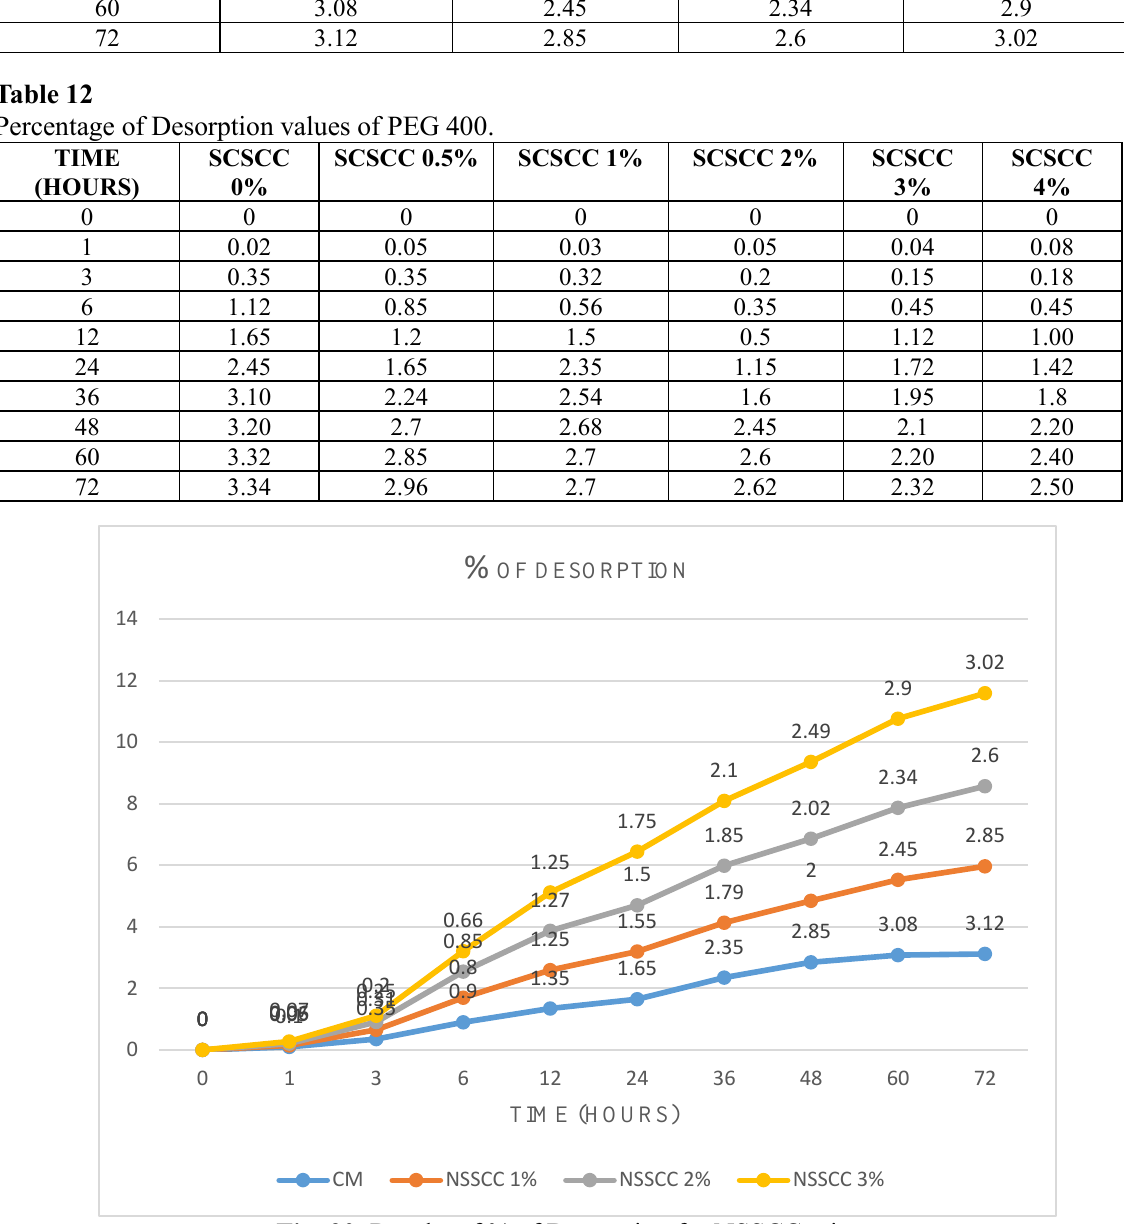
Fig. 30. Results of % of Desorption for NSSCC